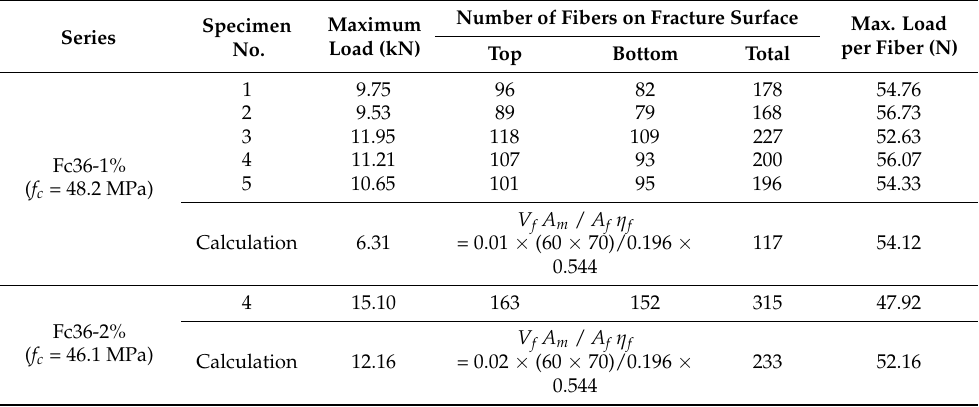
Table 8. Comparison between uniaxial tension test results and bridging law calculation (Fc48 Series). Specimen Series